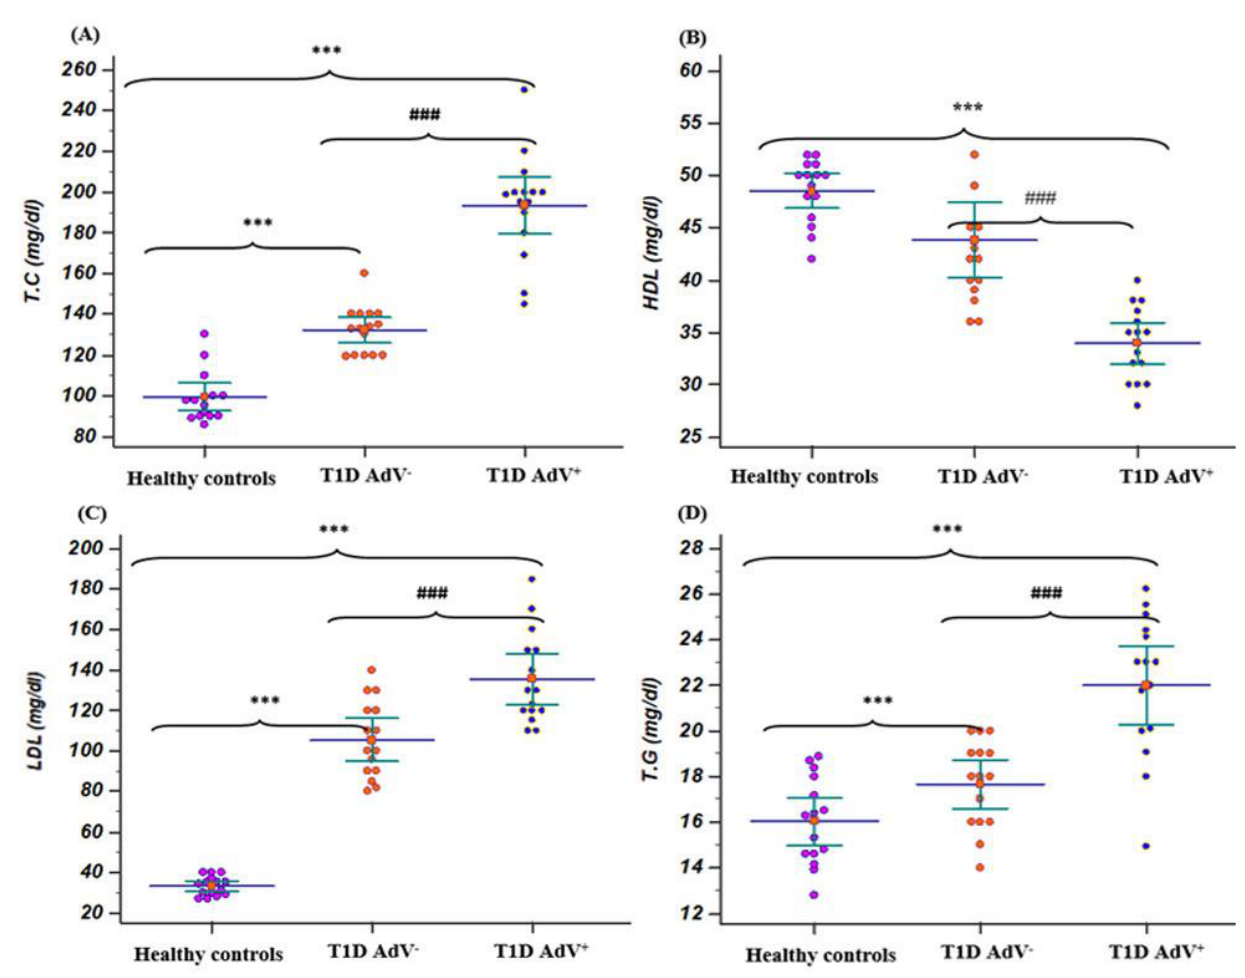
Figure 3. Lipid profile in (T1D—negative AdV (PCR and antibodies) and T1D—AdV positive (PCR) groups in comparison to healthy control. ( A ) Total cholesterol (TC): control group: mean 99.135 ± 3.165 and range 86–130; T1D AdV − : mean 132.26 ± 2.93 and range 119–160; and T1D AdV + : mean 193.26 ± 6.3 and range 145–250; ( B ) high-density lipoprotein. (HDL): control group: mean 48.53 ± 0.779 and range 42–52; T1D AdV − : mean 41.86 ± 1.67 and range 36–54; and T1D AdV + : mean 32.6 ± 1.08 and range 28–42; ( C ) low-density lipoprotein(LDL): control group: mean 33.2 ± 1.21 and range of 27–40; T1D AdV − : mean 121.73 ± 6.92 and range 80–143; and T1D AdV + : mean 143.54 ± 8.17 and range 106–148; and ( D ) triglycerides (T.G): control group: mean 33.2 ± 1.21 and range of 27–40; T1D AdV − : mean 121.73 ± 6.92 and range 80–143; and T1D AdV + : mean 143.54 ± 8.17 and range 106–185. Values were considered significantly different at *** p < 0.001 versus healthy controls, and ### p < 0.001 T1D—AdV − versus T1D—AdV + children.